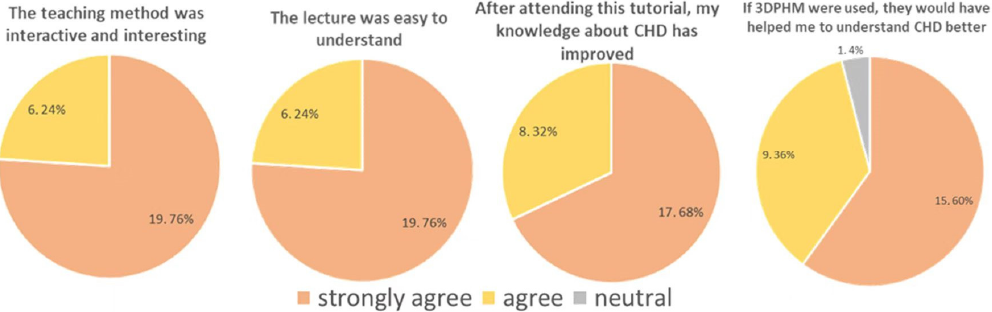
Figure 5. Survey response (number of students, percentage) of the control group with regard to the education session. 3DPHM—3D-printed heart model. Reprinted with permission under the open access from Lau and Sun [49].